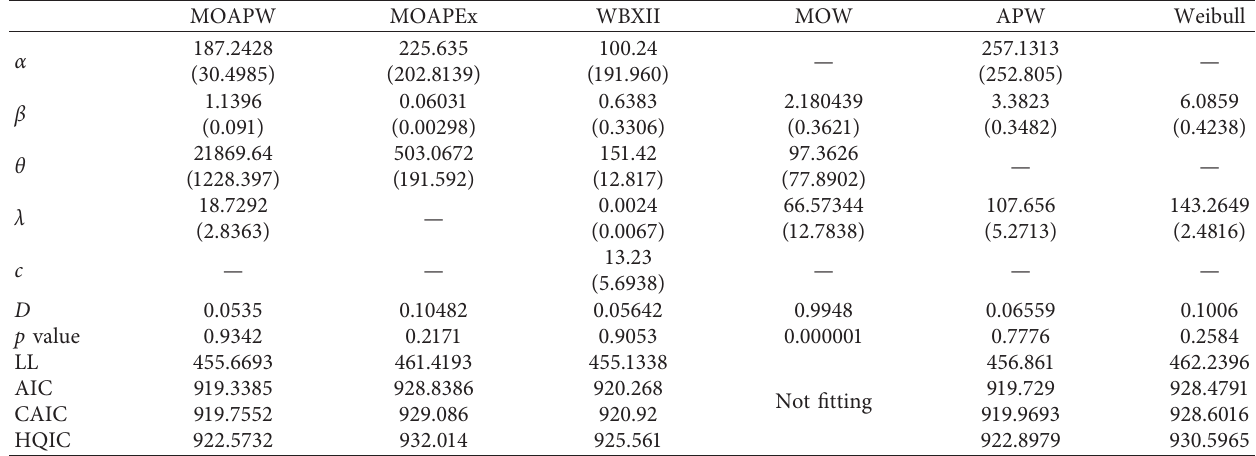
Figure 5: MSE for estimation methods under different schemes for MAOPW: case 1. (a) MSE ( α ). (b) MSE ( β ). (c) MSE ( θ ). (d) MSE ( λ ). Table 6: MLE, standard error (St. E), KS distance, p values, and different criteria for the first data set.